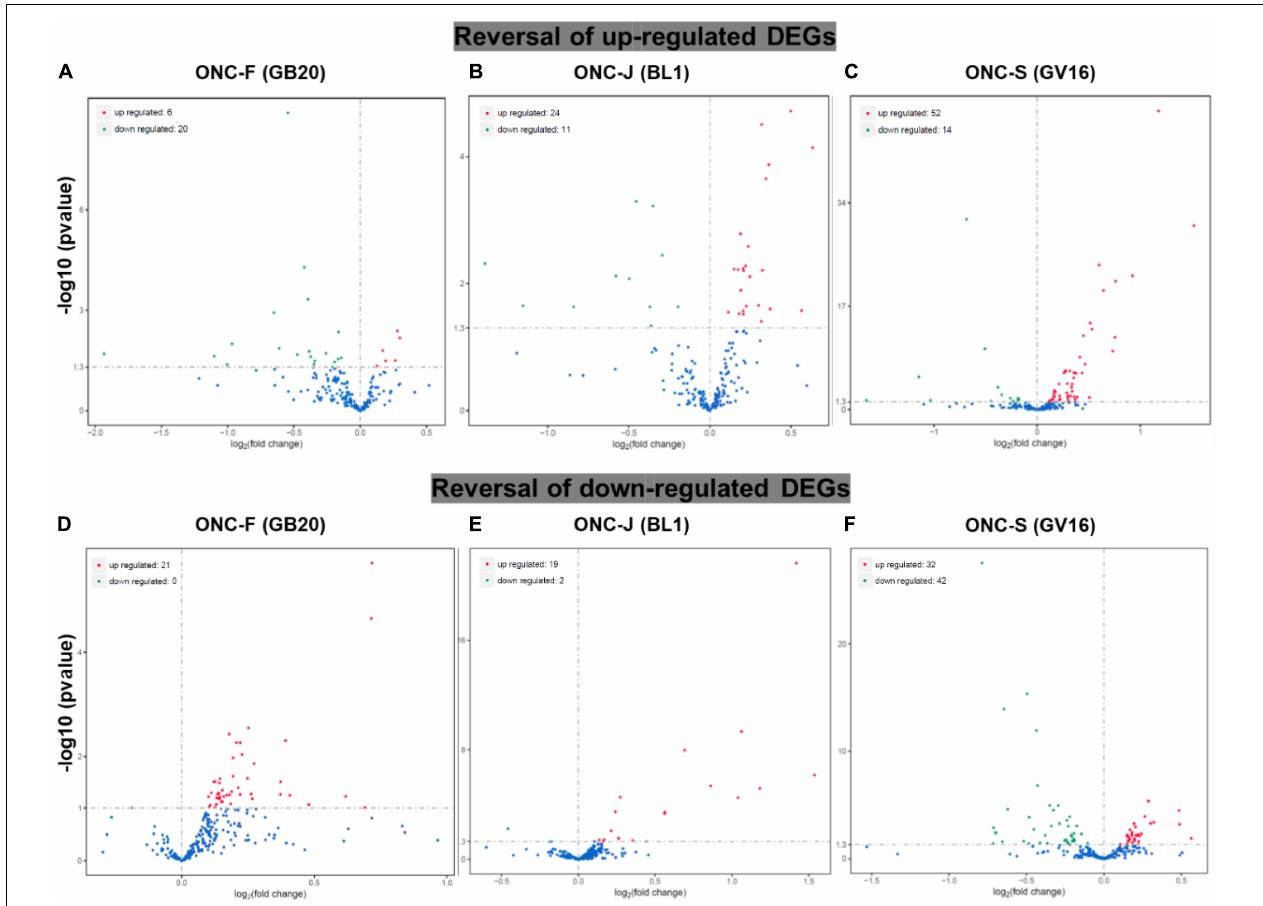
FIGURE 4 | Reversal of DEGs by acupuncture treatment after ONC injury. (A–C) Volcano map shows the reversal of up-regulated DEGs induced by ONC injury after acupuncture treatments at acupoint BL1, GB20, and GV16 (Sham control site). (D–F) Volcano map shows the reversal of down-regulated DEGs induced by ONC injury after acupuncture treatments at acupoint BL1, GB20, and GV16. p value <